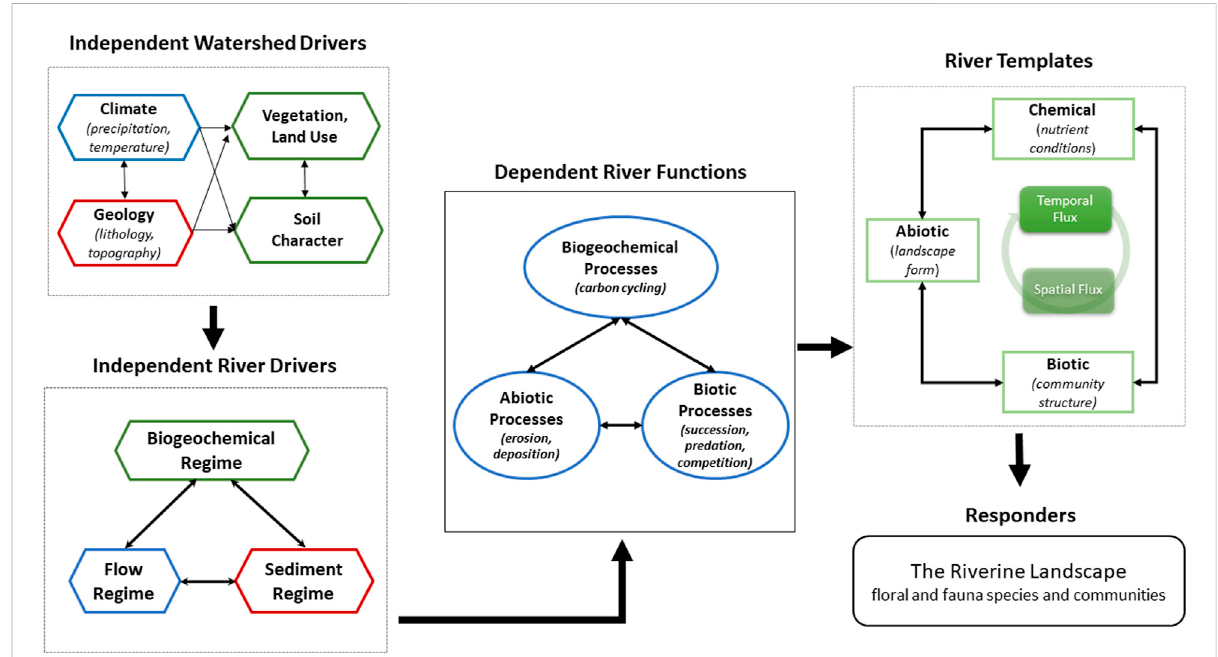
FIGURE 1 A conceptual fl ow-chain model for Functional Flows in riverine landscapes. The shape of each element re fl ects the nature of the element (e.g., Driver, Function, or Template), and the arrows indicate interactions between the